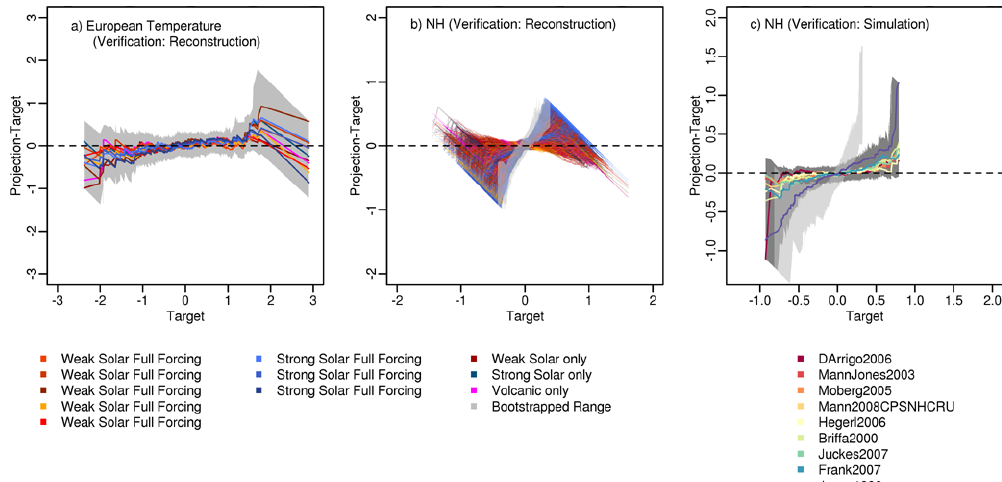
Fig. 5. Evaluation of climatological consistency: residual quantile-quantile plots for temperature data: (a) SIM members against Central Eu- ropean annual temperature target, (b) SIM members against Northern Hemisphere temperature target, (c) FRS against Northern Hemisphere temperature target. Panels account for the uncertainties in the target. See legend for individual ensemble members. Grey shading in (a) and transparent grey overlay in (b–c) are 0.5% and 99.5% quantiles for block-bootstrapped residual quantiles (2000 replicates, block length of 50yr). In (b) we plot all results relative to all used targets including an estimate of internal variability. In (c) the dark grey shading are the bootstrapped quantiles relative to the target including an estimate of simulated internal variability. Middle grey (c) is due to the